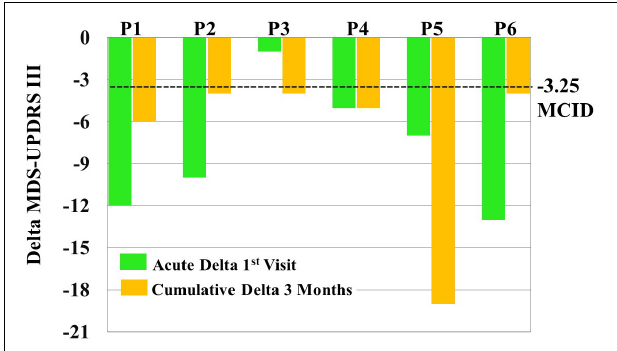
FIGURE 6 | To assess clinical significance of acute and cumulative treatment outcomes, minimal clinically important differences (MCID = –3.25) were compared to Movement Disorders Society-Unified Parkinson’s Disease Rating Scale (MDS-UPDRS) score changes [i.e., Delta MDS-UPDRS III = post-vibrotactile coordinated reset (vCR) MDS-UPDRS III minus pre-vCR MDS-UPDRS III] obtained by subtracting pretreatment (baseline)